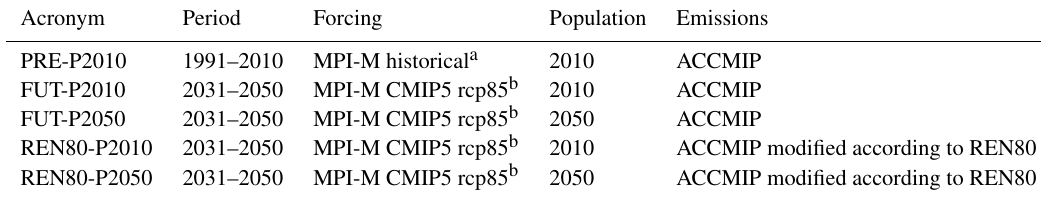
Table 3. Summary of cases considered for the estimation of premature deaths over Europe.